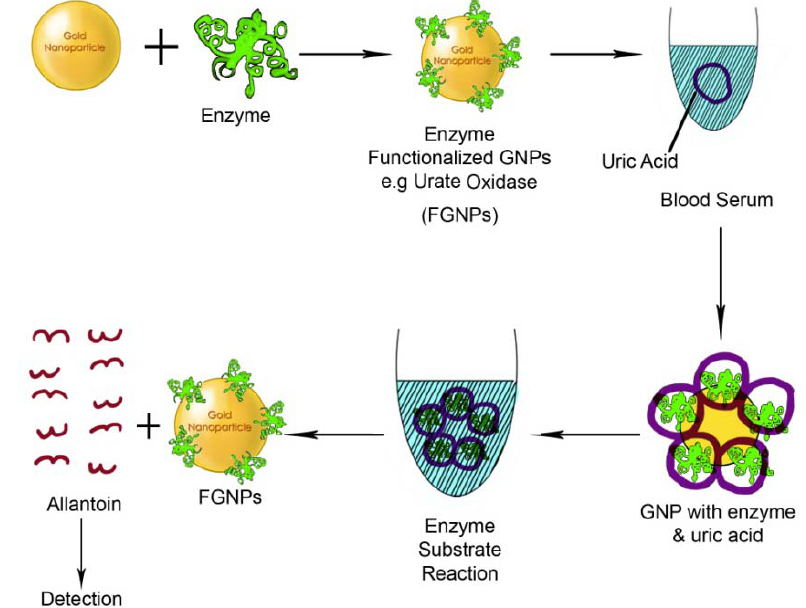
Figure 5. fGNP based biosensor for the detection of serum